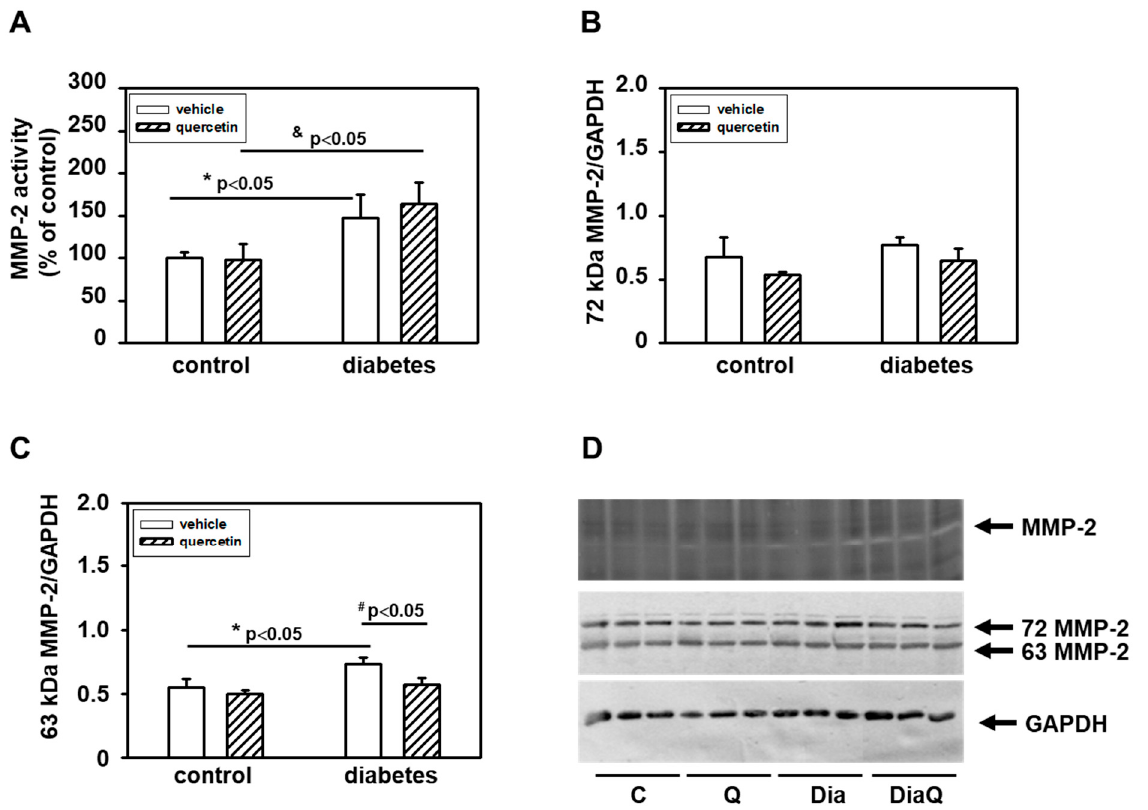
Figure 2. ( A ) Quantitative analysis of the tissue 72-kDa matrix metalloproteinase-2 (MMP-2) activities. Activities were analyzed using gelatin zymography and data are expressed as a percentage of value for corresponding control. Each bar represents mean ± SEM ( n = 6–7) and statistical significance was revealed by Student’s unpaired t -test, * p < 0.05 vs. control lean vehicle-treated rats, & p < 0.05 vs. control lean quercetin-treated rats. ( B ) Quantification of 72-kDa MMP-2 content normalized to the GAPDH protein levels. ( C ) Quantification of 63-kDa MMP-2 content normalized to the glyceraldehyde-3-phosphate dehydrogenase (GAPDH) protein levels. Data were obtained from Western blot records and each bar represents mean ± SEM, n = 6–7. Statistical significance was revealed by Student’s unpaired t -test, * p < 0.05 vs. control lean vehicle-treated rats, # p < 0.05 vs. obese diabetic vehicle-treated rats. ( D ) At the top is a record showing the activities of MMP-2 analyzed using gelatin zymography; in the middle, a Western blot record showing MMP-2 protein levels analyzed using a specific antibody that reacts with both the 72 and 63 kDa forms of MMP-2, and at the bottom the protein loading using GAPDH is documented. C—control lean vehicle-treated ZDF rats; Q—lean quercetin-treated ZDF rats;